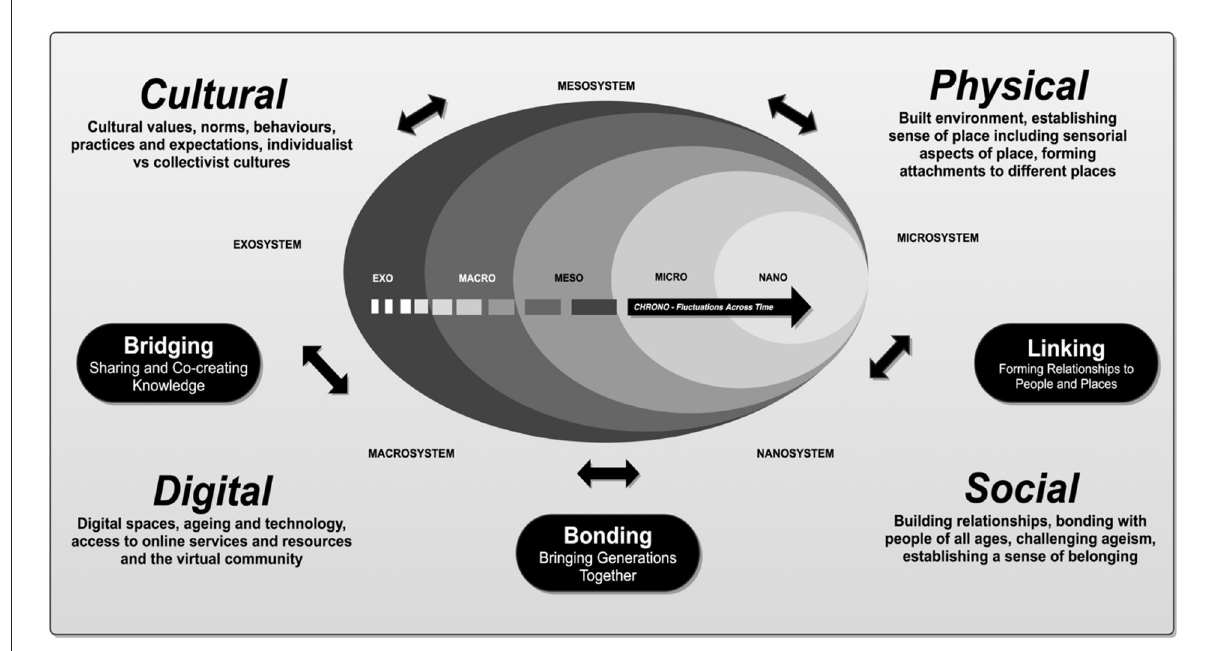
FIGURE1 AFLE according to Bronfenbrenner’s ecological systems theory. Illustrates how the various ecosystems and levels interact to influence wellbeing.